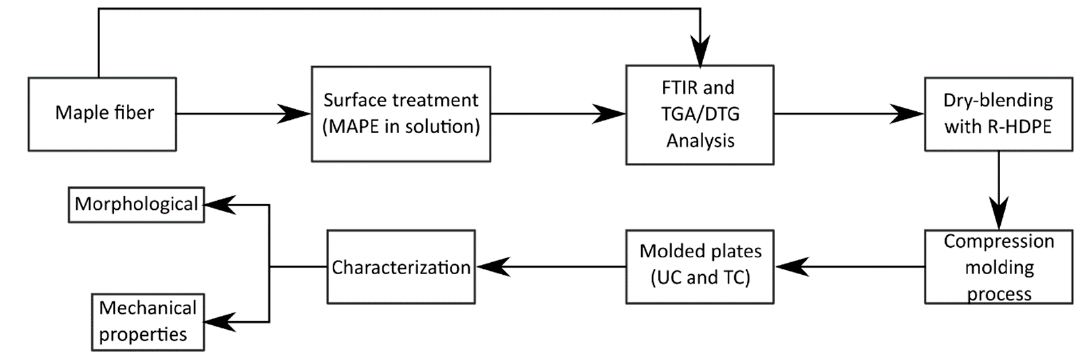
Figure 2. Schematic representation of the processing sequence to produce untreated (UC) and treated fiber (TC) composites with their characterization.